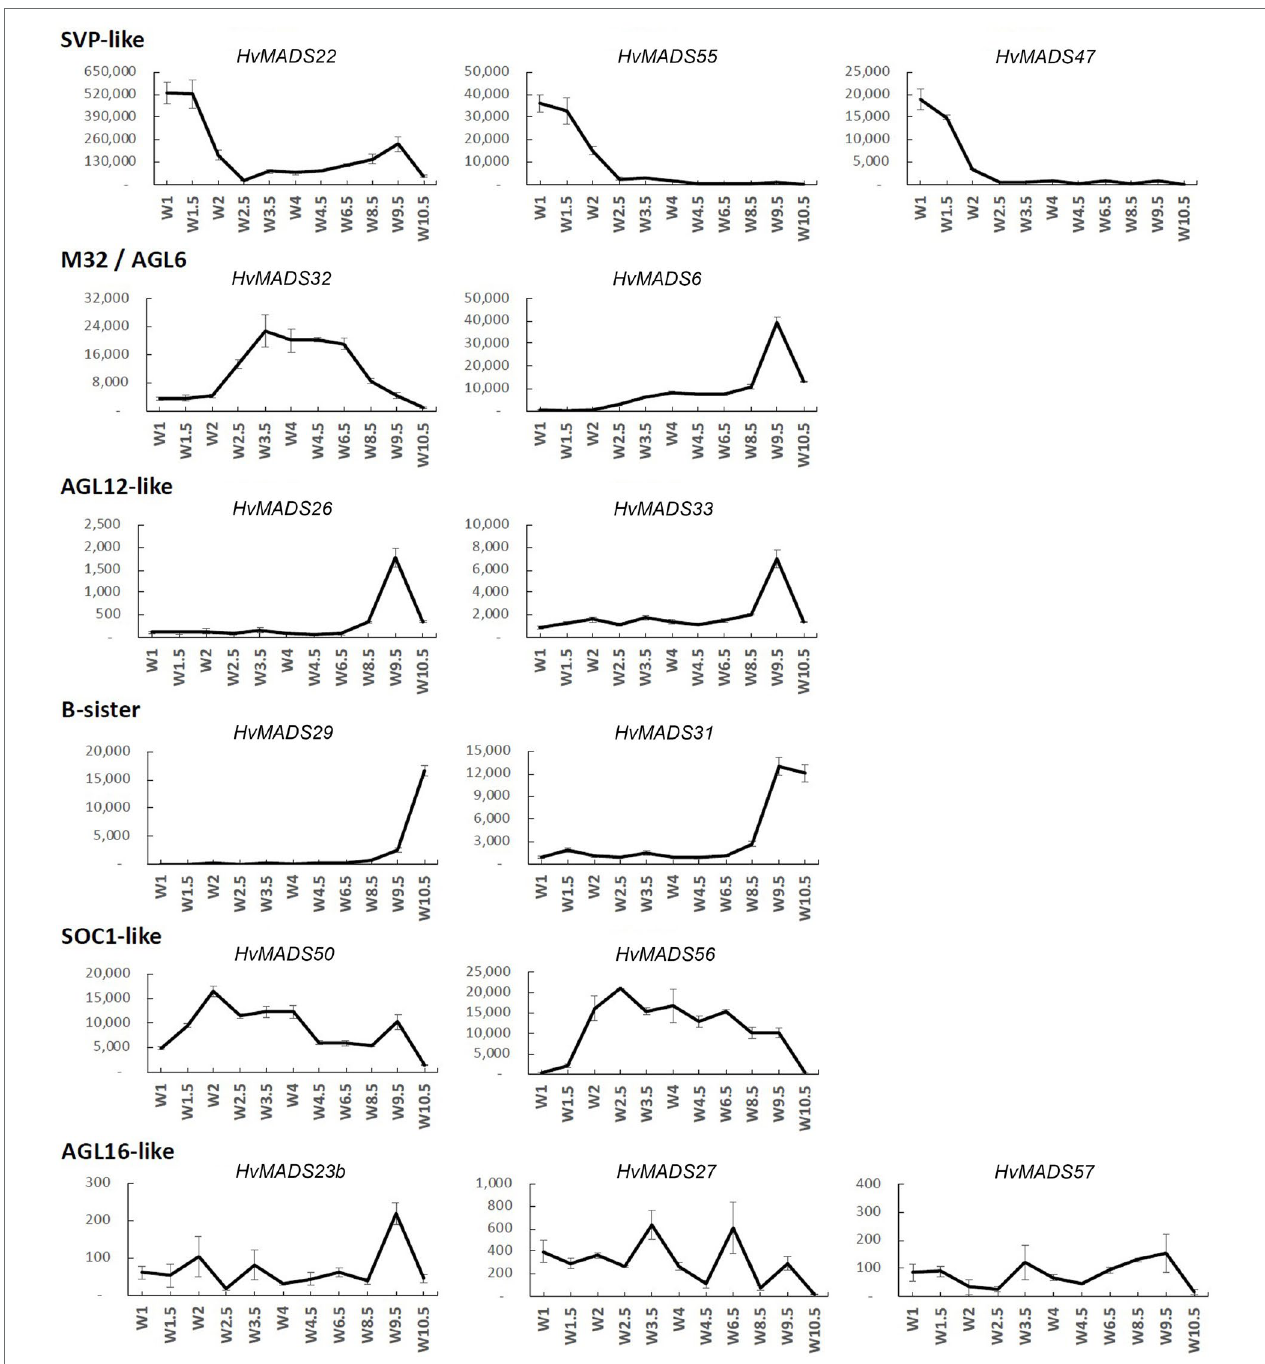
FIGURE 4 | Transcript profile of the non-ABCDE MIKCc MADS-box genes through inflorescence development by Waddington stage in Golden Promise. Error bars represent one standard deviation, based on technical